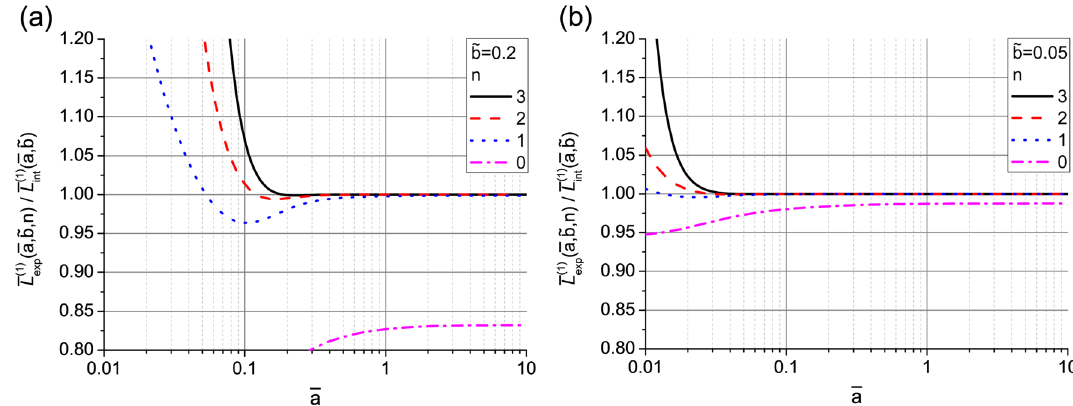
( ¯ a , ˜ b , n ) is the expansion (15) up to O ( ˜ b 2 n ) , and exp